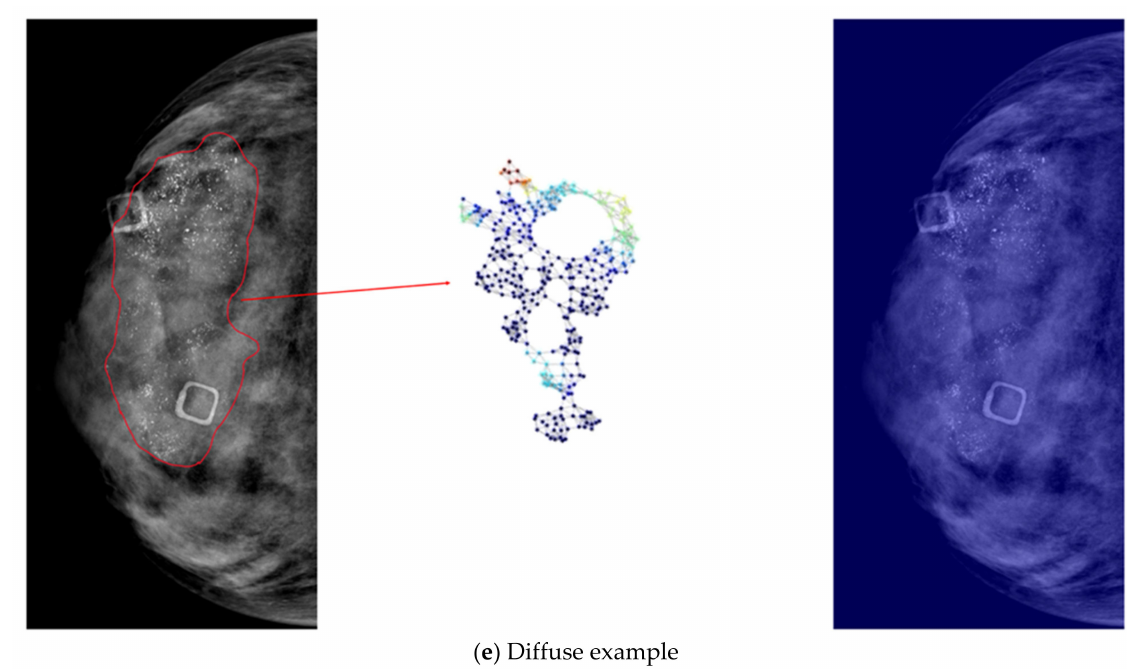
Figure 5. Visualizations of calcification diffusion patterns. One example from each distribution category is selected to be shown in ( a – e ). In each left panel, the radiologist’s annotation is outlined in red. Each middle panel shows the graphical saliency map for the corresponding image. Nodes are color-coded according to importance, where blue indicates low importance to the proposed network, yellow indicates medium importance, and red indicates high importance. Each right panel shows the saliency map using the ResNet